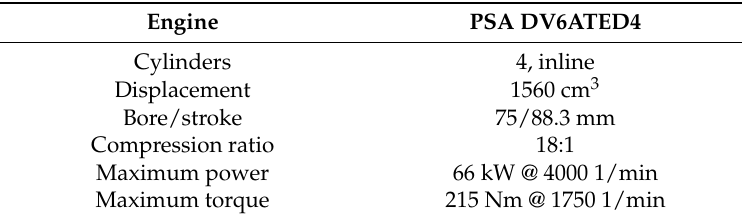
Table 3. PSA engine characteristics.